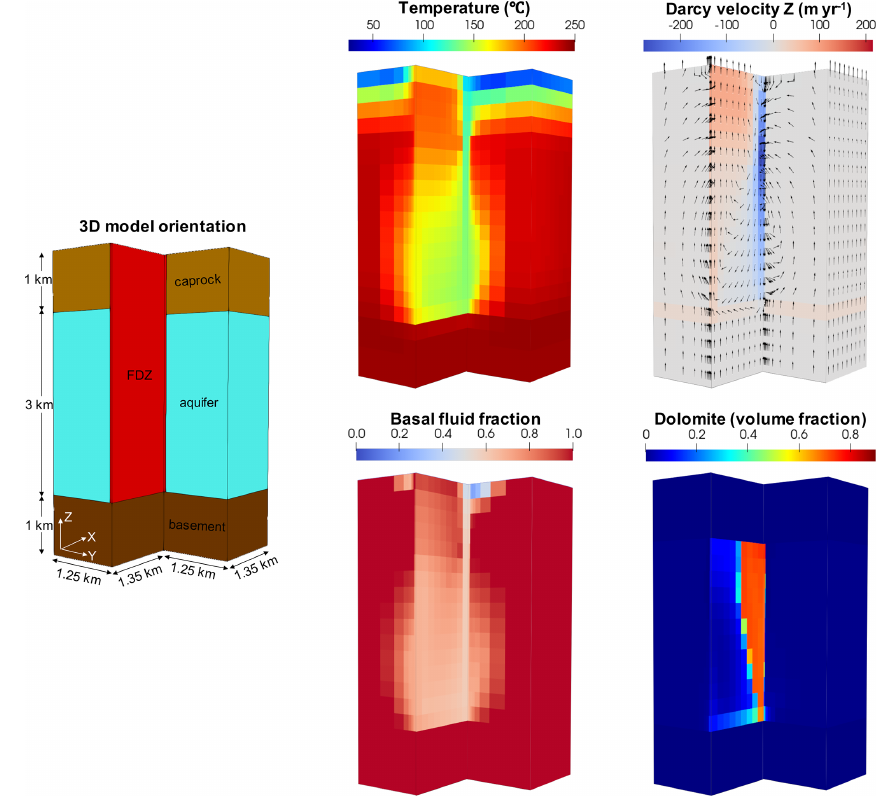
Figure 3. A 3D baseline simulation illustrating heat transfer, fluid flow, basal fluid fraction, and dolomite distribution at 30kyr. Note that the Darcy velocities are positive when the flow is upward and negative when the flow is downward. The 3D volume on the left represents the orientation and dimensions of the displays. The dolomitisation is focused along the plane of the fault for which the temporal evolution of the system is presented in Fig.